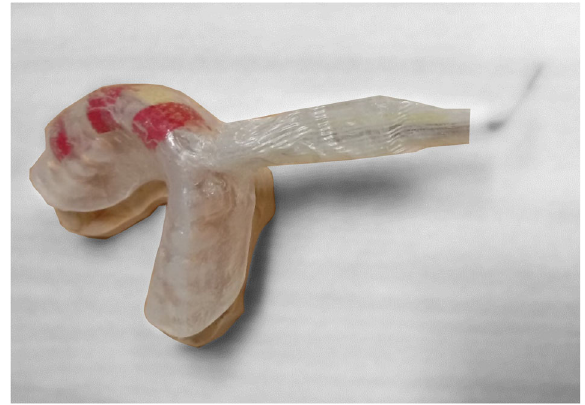
Fig. 2 An EVA encased mouthguard situated on top of the cast with a data acquisition system embedded. A cable is used to connect it with the MAX30208 Evaluation System. Red electric tape is used to keep the wires in place during the forming process, while a yellow pH sensitive comparator paper strip is positioned along the wires to detect potential water ingression.